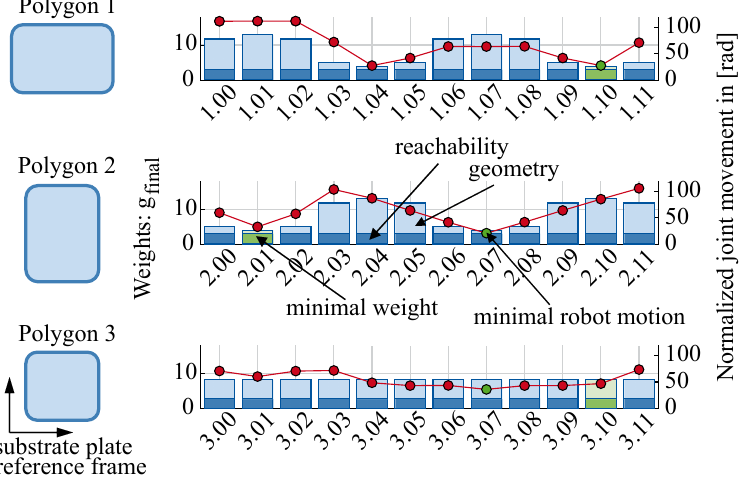
Figure 19. Exemplary infill weights compared with the real robot motion after trajectory planning (cf. Formula (2)).